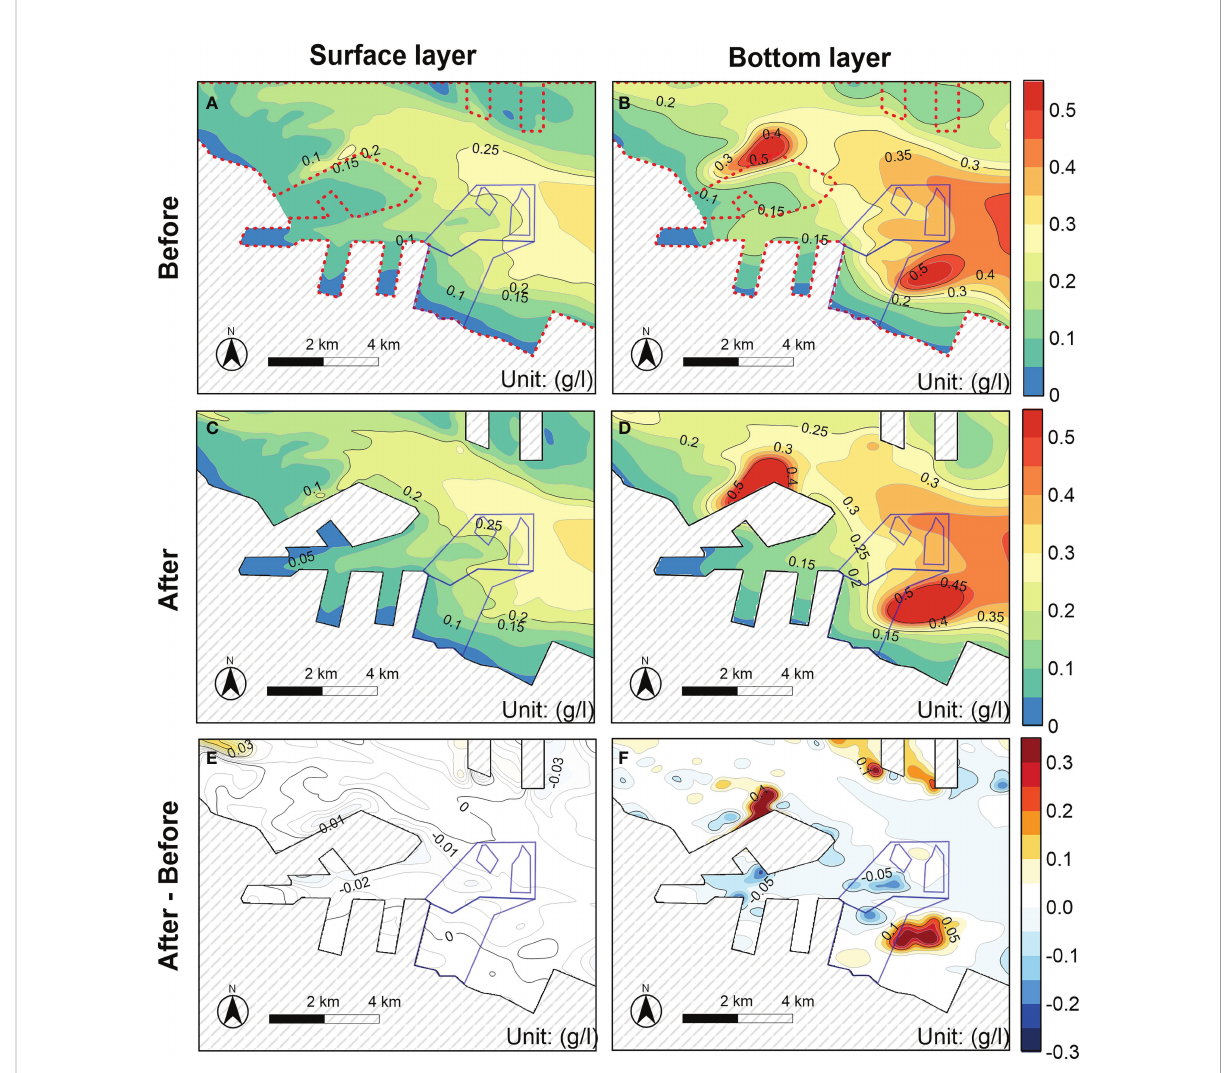
FIGURE 11 Comparison of surface and bottom sediment concentrations before and after human engineering activity. The locations of oyster reefs and their subdivisions are marked on the fi gures with solid blue lines. (A) Surface and (B) bottom sediment concentration distribution during the fl ood tide of spring tide before construction of the project. (C) Surface and (D) bottom sediment concentration distribution during the fl ood tide of spring tide after construction of the project. Difference in (E) surface and (F) bottom sediment concentration distribution during the fl ood tide of spring tide before and after construction (sediment concentration before construction minus sediment concentration after